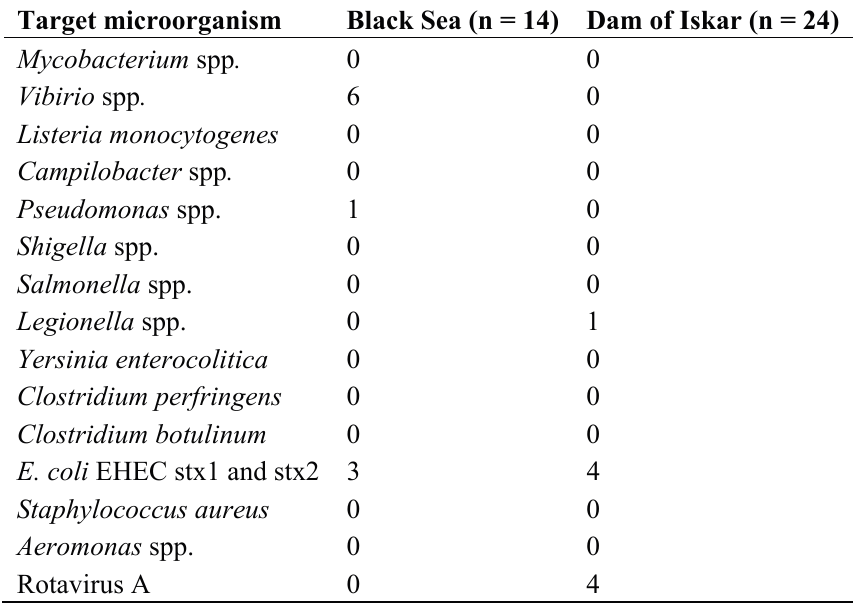
Table 1. Occurrence of targeted pathogens from environmental water obtained from the Black Sea and the Dam of Iskar during the two year monitoring campaign. The results are based on qPCR and regular